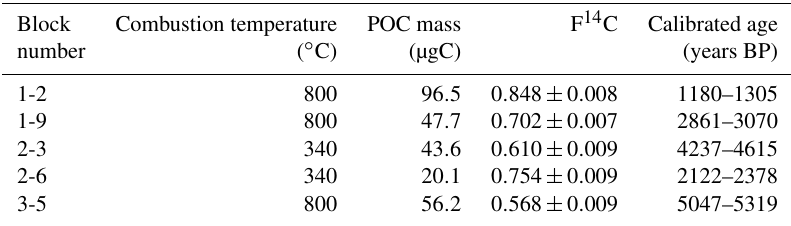
Table 1. POC 14 C dating results for the samples from Titlis glacier cave. The sample names denote the profile and the block number as indicated in Fig. 2. The additional temperature in the sample name refers to the POC combustion temperature. The F 14 C value is given according to the convention stated in Stuiver and Polach (1977). The calibrated ages have been calculated using OxCal version 2.4 (Ramsey, 1995). All calibrated ages are reported as their 1 σ ranges in years before present